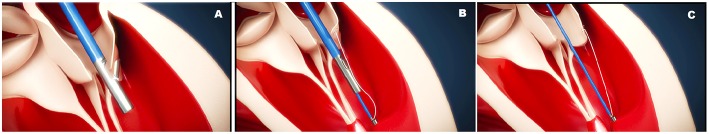
The CardioMech implantation procedure steps. (A) PML is grasped and punctured. (B) The artificial chord is anchored to the papillary muscle. (C) The chord is tensioned.